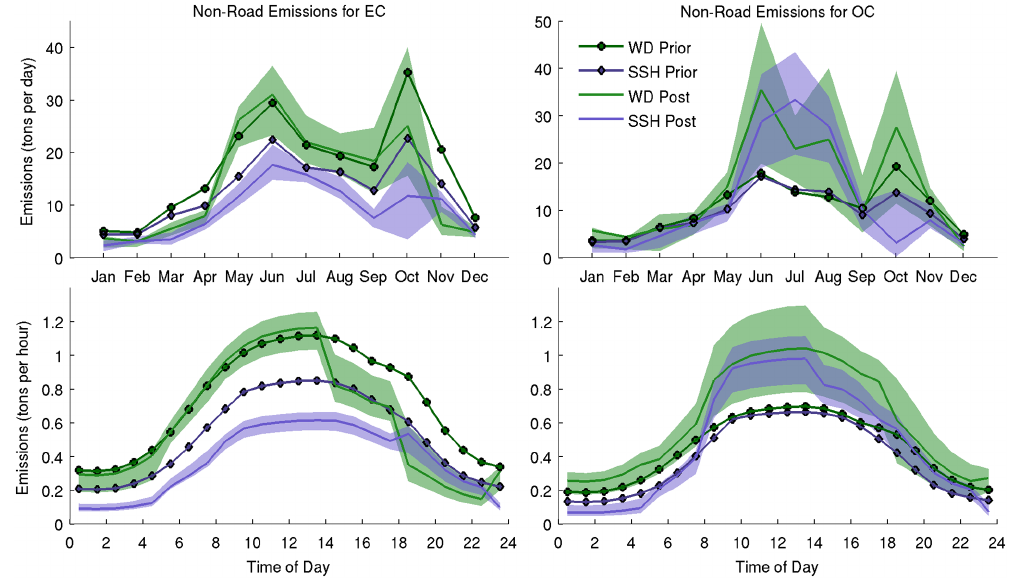
Figure 11. Monthly and diurnal temporal pattern of emissions of EC and OC for non-road emissions by weekday and weekend for the St. Louis region, see Fig.